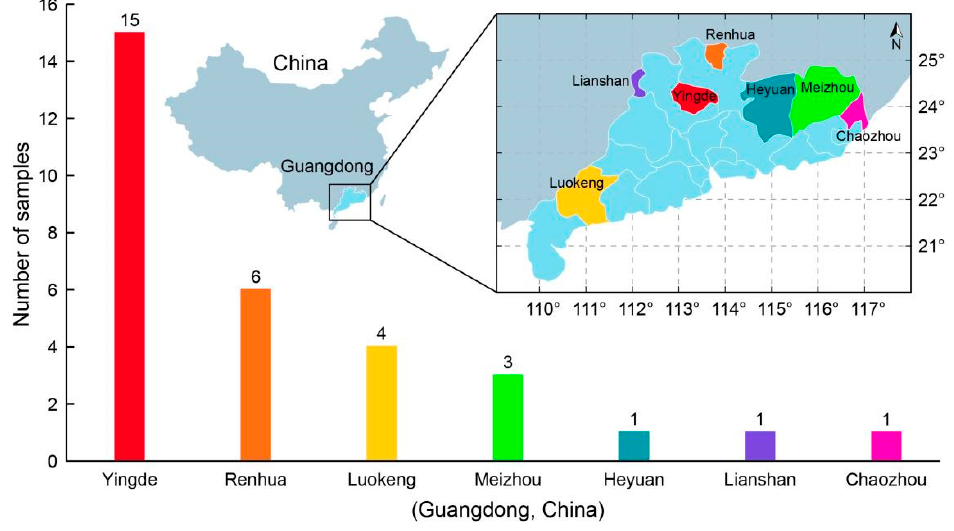
Figure 1. Black tea samples in Guangdong Province, China.